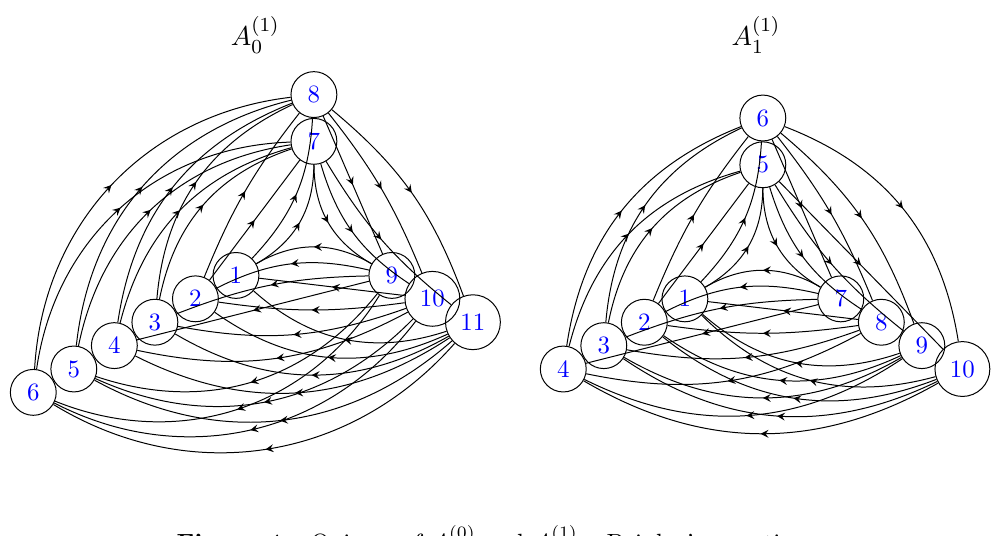
and A (1) q -Painlev’e 0 1